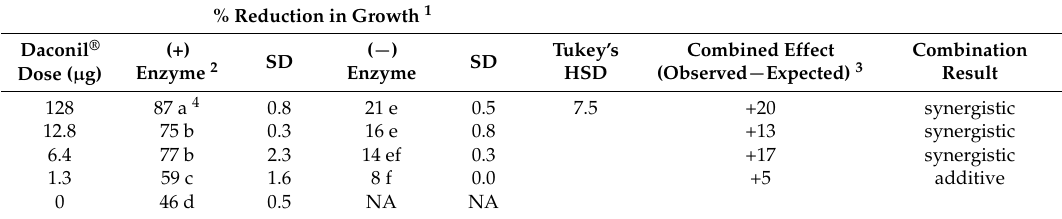
Table 3. Inhibition of Pythium ultimum by the stabilized lactoperoxidase (LPO) formulation alone and in combination with Daconil ® using fungicide-impregnated filter paper